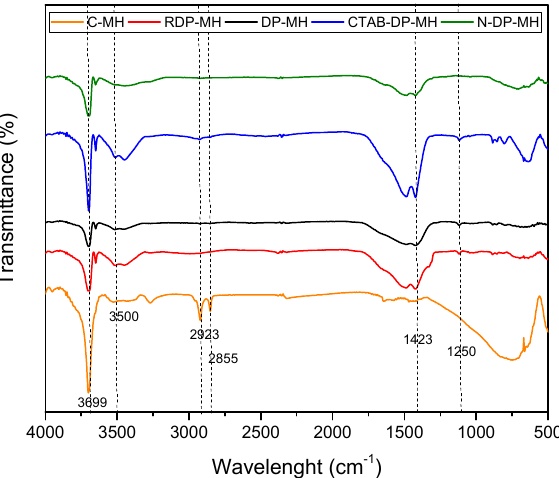
Figure 2. Fourier transform infrared (FT-IR) analysis of investigated samples.